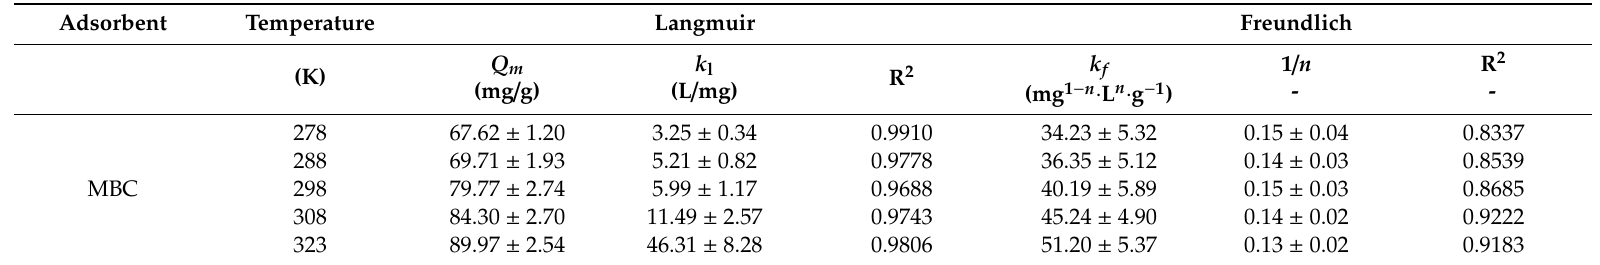
Table 2. Langmuir and Freundlich parameters of As(V) adsorption by